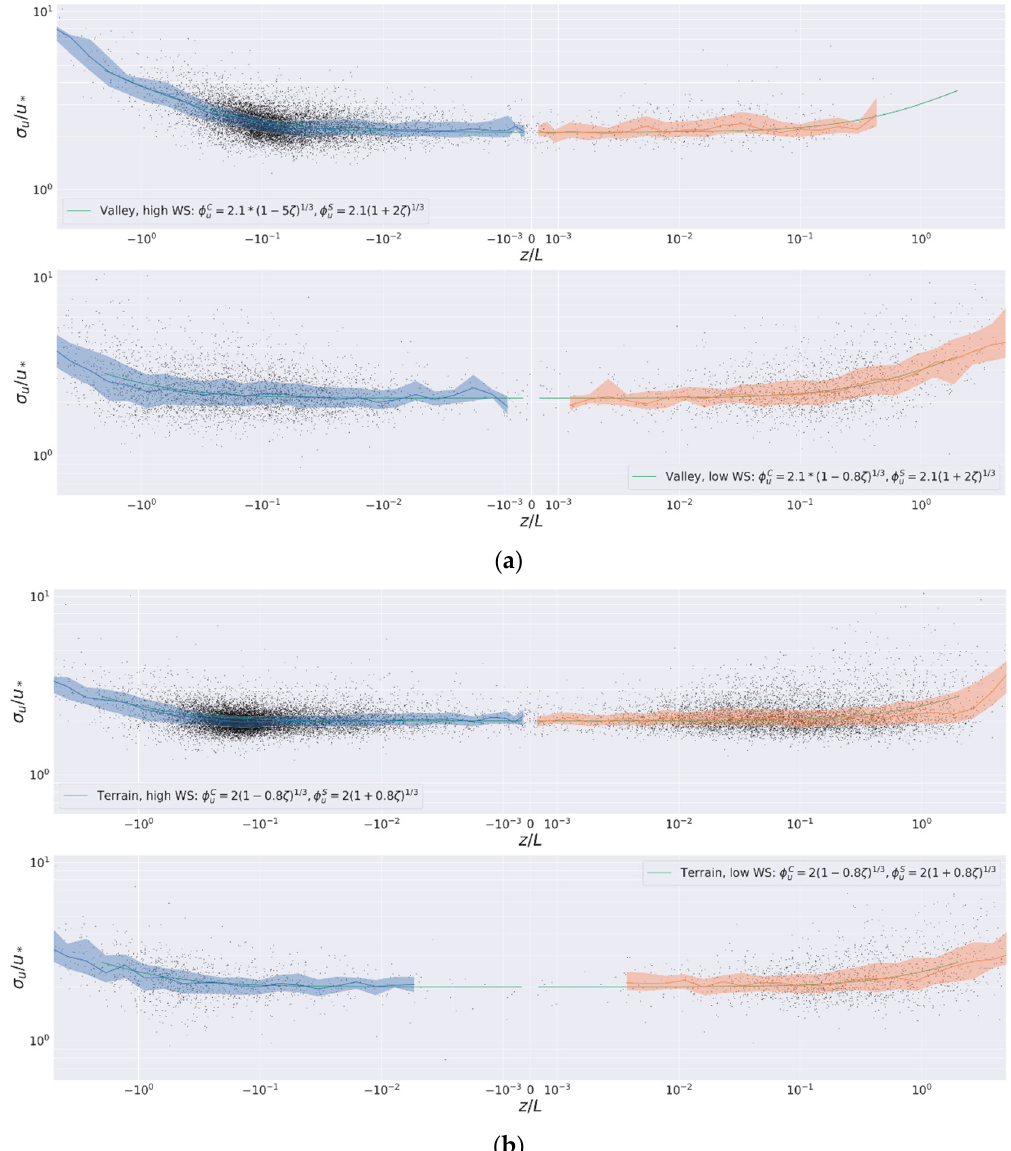
Figure 5. The dimensionless turbulence parameters for σ u / u ∗ , the along-wind horizontal standard deviation of the wind velocity fluctuations, plotted as functions of z / L both for weak wind ( U ≤ 1 m wind ( U > 1 m/s; upper part for each station); The Zevulun valley region, as represented by the Z2 (Kiryat Motzkin) weather station is shown in ( a ), while the Mount Carmel region, as represented by the C9 (Tel Hai elementary school, Haifa) weather station is shown in ( b ).